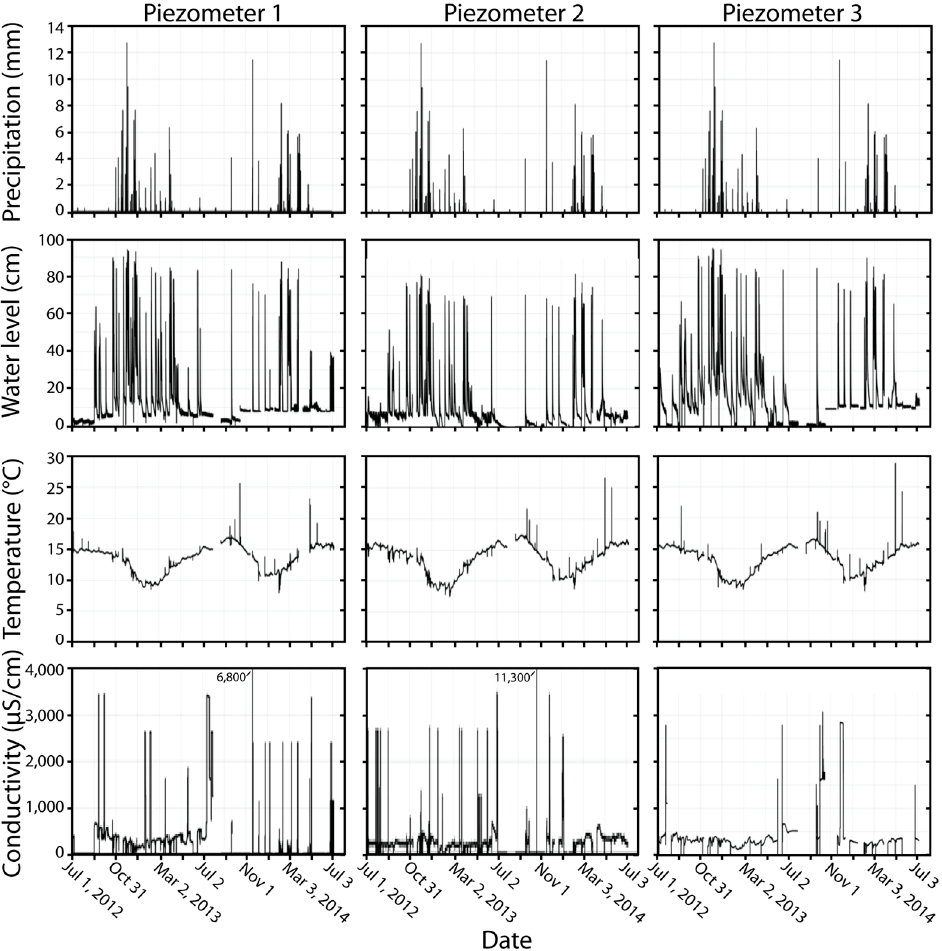
Figure 3. Hourly time series of precipitation (mm), water levels (cm), temperature (°C), and conductivity ( μ S/cm) in piezometers 1, 2, and 3 during the period of observation (July 2012 to July 2014).